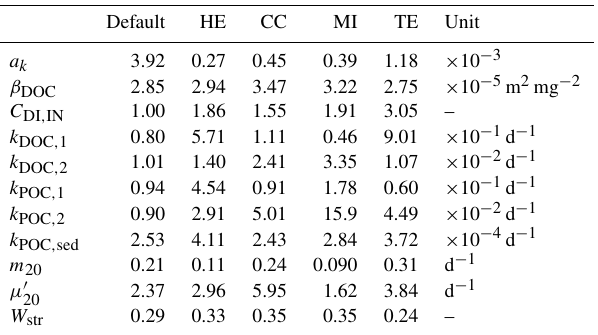
Table 2. Calibrated model parameters for the different versions of MyLake C application to Lake Kuivajärvi with different incorpo- rated gas exchange models (HE: Heiskanen et al., 2014, CC: Cole and Caraco, 1998, MI: MacIntyre et al., 2010, TE: Tedford et al., 2014). The default parameter values were used as the means of the prior parameter